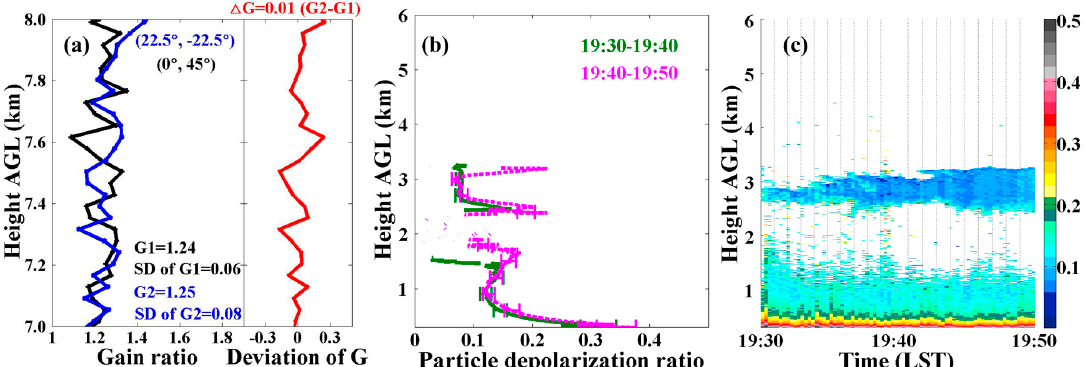
Figure 11. ( a ) Gain ratio determined during TIPEX III 2014 in Naqu; ( b ) Profile of particle depolarization ratio (dark green line) with error bar (horizontal line) and ( c ) temporal development of particle depolarization ratio measured on 12 August 2014 in Naqu.